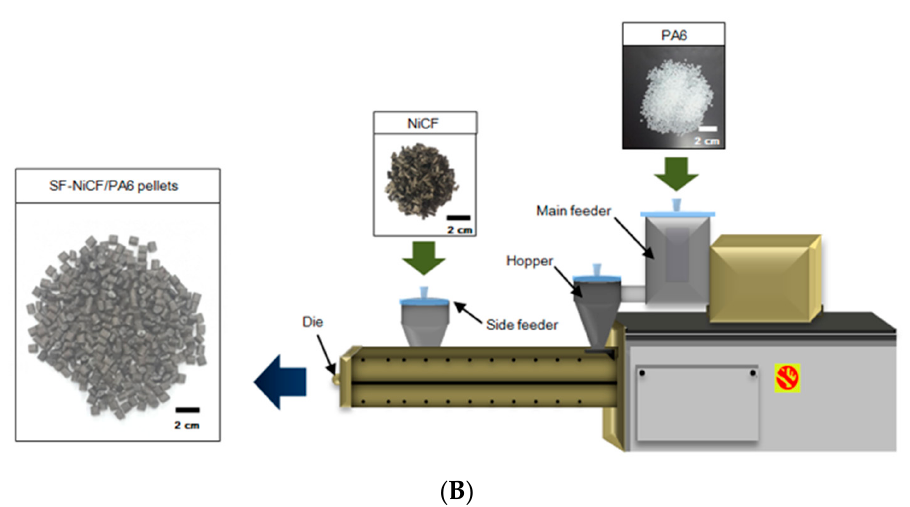
Figure 1. Extrusion processing to produce ( A ) MF-NiCF/PA6 and ( B ) SF-NiCF/PA6 pellets using a twin-screw extruder.